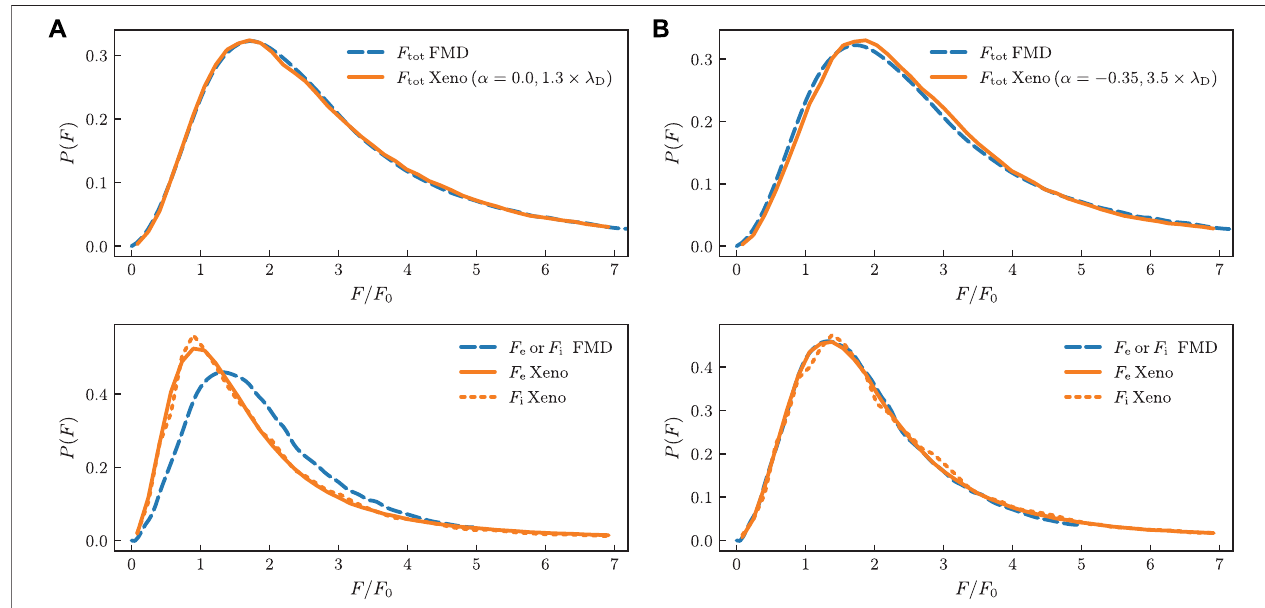
FIGURE 3 | Comparison of electric fi eld distributions of the non-interacting simulations of Xenomorph with those from the FMD simulations of Stambulchik et al. (2007).Thetoppanelof (A) showsthattheFMDdistributioncanbeverywellreproducedwith ~ λ (cid:2) 1 . 3 λ D ,whilethelowerpanelshowsthatthedistributionsoftheelectron and ion fi elds do not match the those of the FMD. In (B) we show that with a proper choice of the correlation parameter α and ~ λ (cid:2) 3 . 5 λ D that both individual ion and electron distributions can be reproduced (lower panel) but also that the total electric fi eld distribution is well